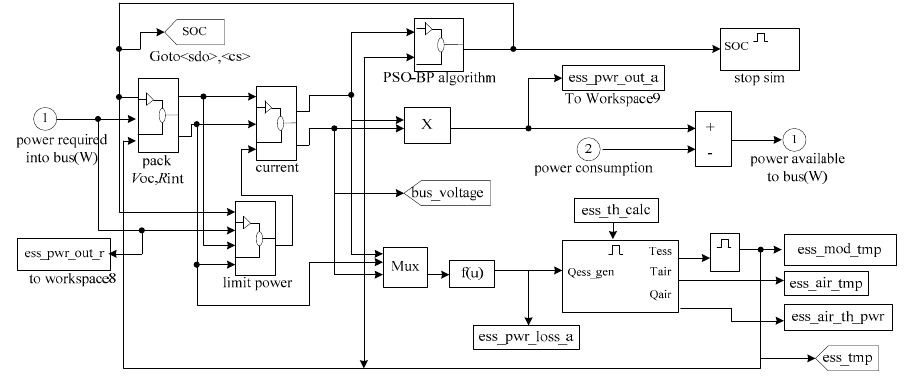
Figure 4. HESS energy storage power calculation model.